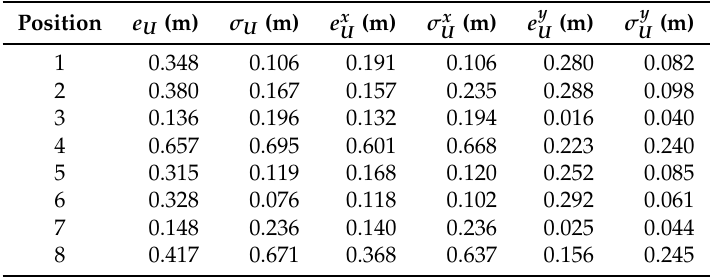
Table 2. Measured accuracy of the POST U algorithm in Scenario 1.